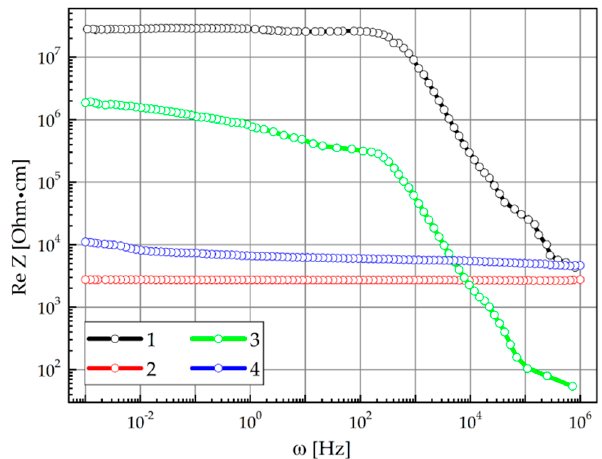
Figure 6. Frequency dependences of the real part of the complex impedance of non-intercalated 4-fold expanded GaSe matrix (1 black) and synthesized GaSe(CS(NH 2 ) 2 ) (2 red), GaSe(SmCl 3 ) (3 green) and GaSe(CS(NH 2 ) 2 (SmCl 3 )) (4 blue) structures measured along the crystallographic C axis.